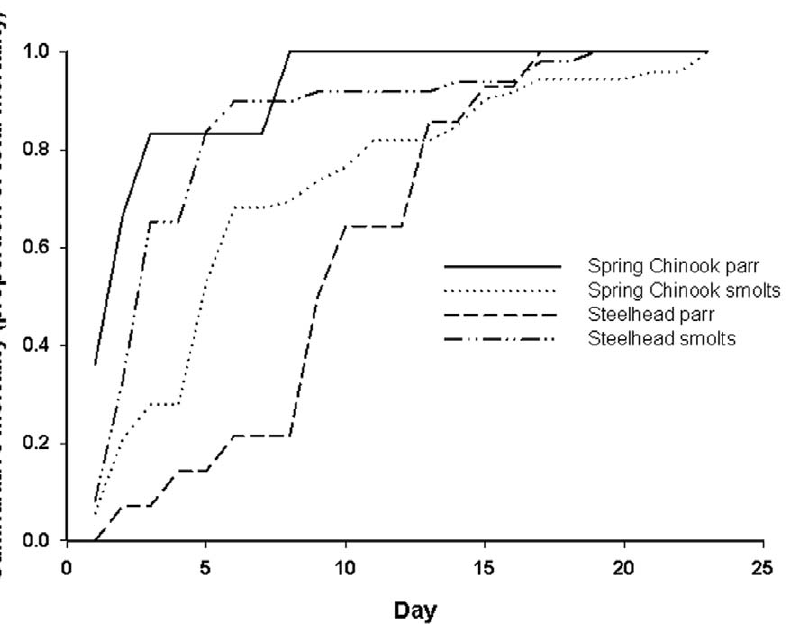
Figure 3. Index of cumulative mortality in juvenile Chinook and steelhead parr and smolts. Juvenile Chinook and steelhead parr and smolts were fed cured eggs for a period of 23 d. We calculated cumulative mortality by summing the number of fish that died each day for all treatment groups (calculated separately for each lifestage and species) fed cured eggs and dividing this by the total number of fish that died during the 23 d period.